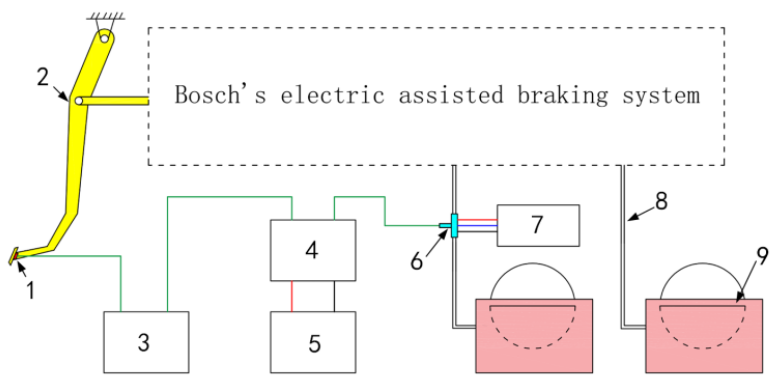
Figure 3. Composition of braking data acquisition test bench: 1. WT901CM attitude sensor, 2. brake pedal, 3. PC Software, 4. NI acquisition card, 5. NI acquisition card chassis, 6. oil pressure sensor, 7. DC power supply, 8. oil pipe, 9. brake caliper.